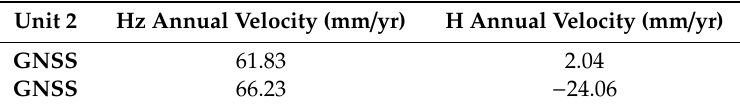
Figure 13. Time series of the 3D displacements observed at the landslide’s head. Table 5. Comparison of the horizontal (Hz) and vertical (H) annual velocities at the site of unit 2, acquired by GNSS monitoring in 2010–2011 [37] and by current GNSS monitoring.